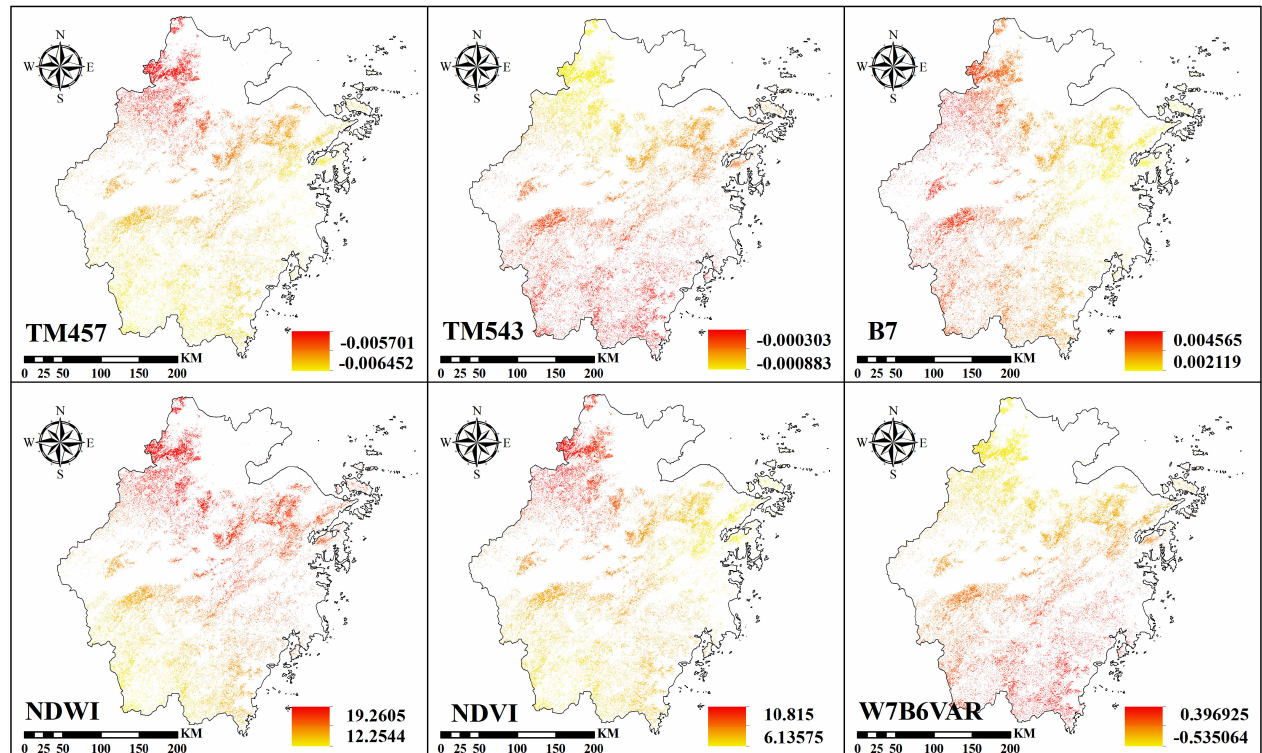
Figure 6. Spatial distribution of model coefficients for different variables in the GWR